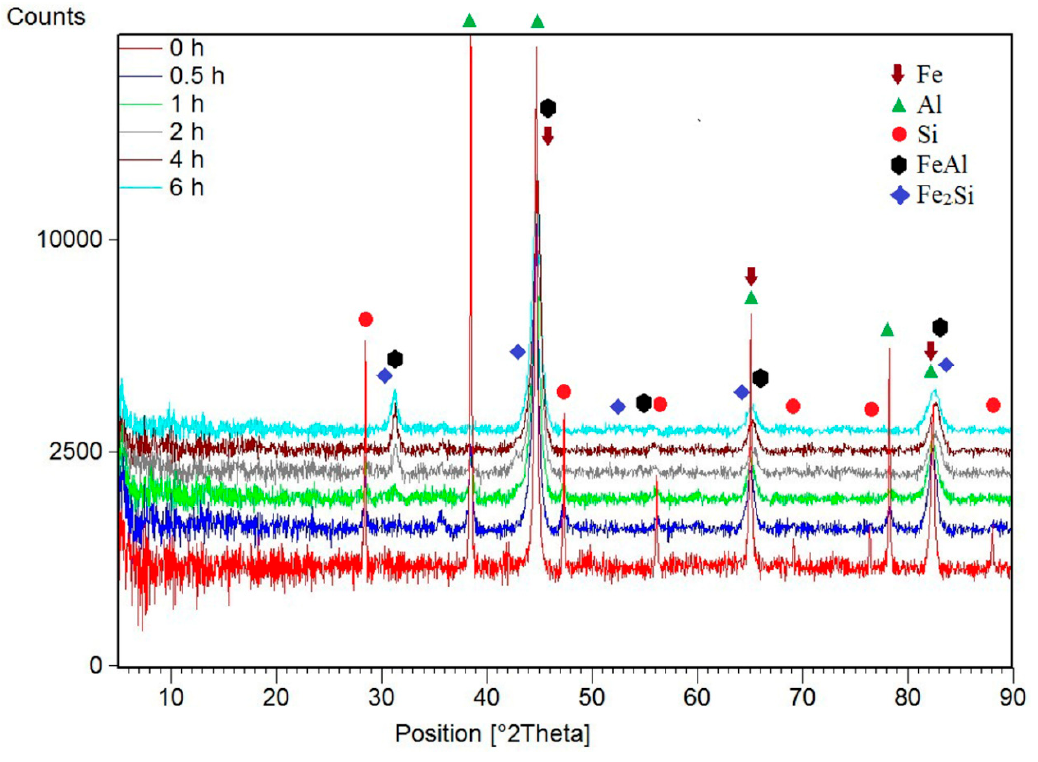
Figure 2. Phase composition of FeAl30Si10 alloy vs. milling time. Table 2. Phase composition vs. milling time for FeAl30Si10 alloy.